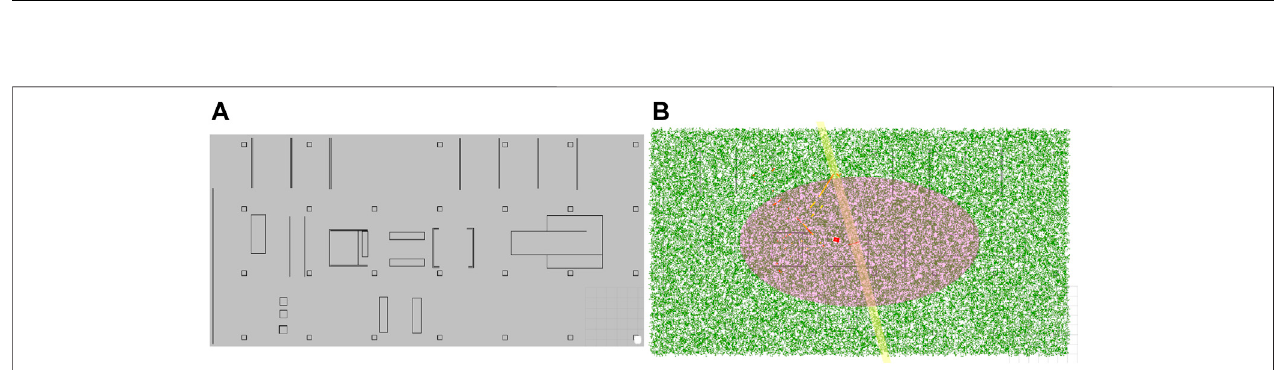
FIGURE8| Amapoftheenvironment,withthetrajectoriesdrivenbytherobotindicatedaspathsandtheirstartinglocations(indifferentcolorsforclarity).Themap containslinesegments,corners(bluepoints)andvisiblenormalsindicatedinpurple.Theworldcontainsunmappedobjectsthatareencounteredduringeverydayuseof the environment. To show how these unmapped items in fl uence the LiDAR readings, an occupancy grid map has been aligned to the map for visualization purposes only. The features shown are linked to semantic object instances, but these are omitted in the fi gure for clarity. The starting region for scenario A is shown in red.